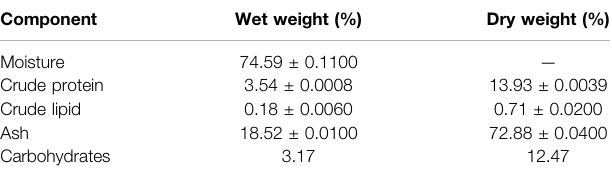
TABLE 3 | DPPH radical scavenging effect of jelly fi sh collagen (JC) jelly fi sh collagen peptide (JCP) company “ T ” tilapia peptide, “ collactive ” collagen peptide, “ matrix ” collagen peptide, and